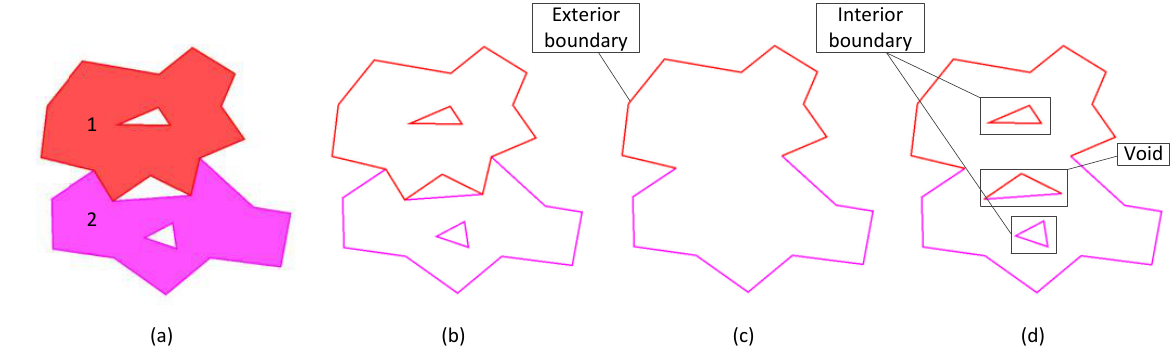
Figure 5. Three types of quasi-voids: interior boundary, exterior boundary and void: ( a ) two simple input meshes; ( b ) the boundaries of mesh 1 and mesh 2; ( c ) exterior boundary of the multi-labeled mesh; ( d ) interior boundary and void of the multi-labeled mesh.